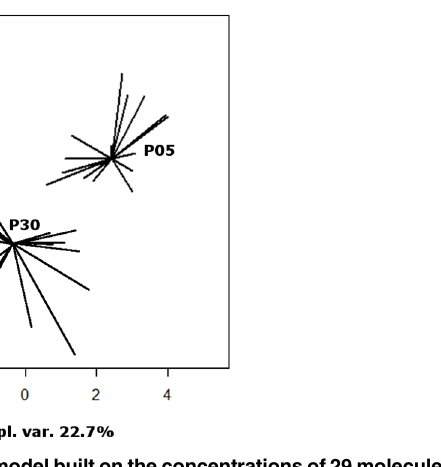
Fig 2. Scoreplot of a PCA model built on the concentrations of 29 molecules listed in Table 1. For each group, segments are drawn from each sample position to the median of the group. “ Expl.Var. ” stands for explained variance of the original data.